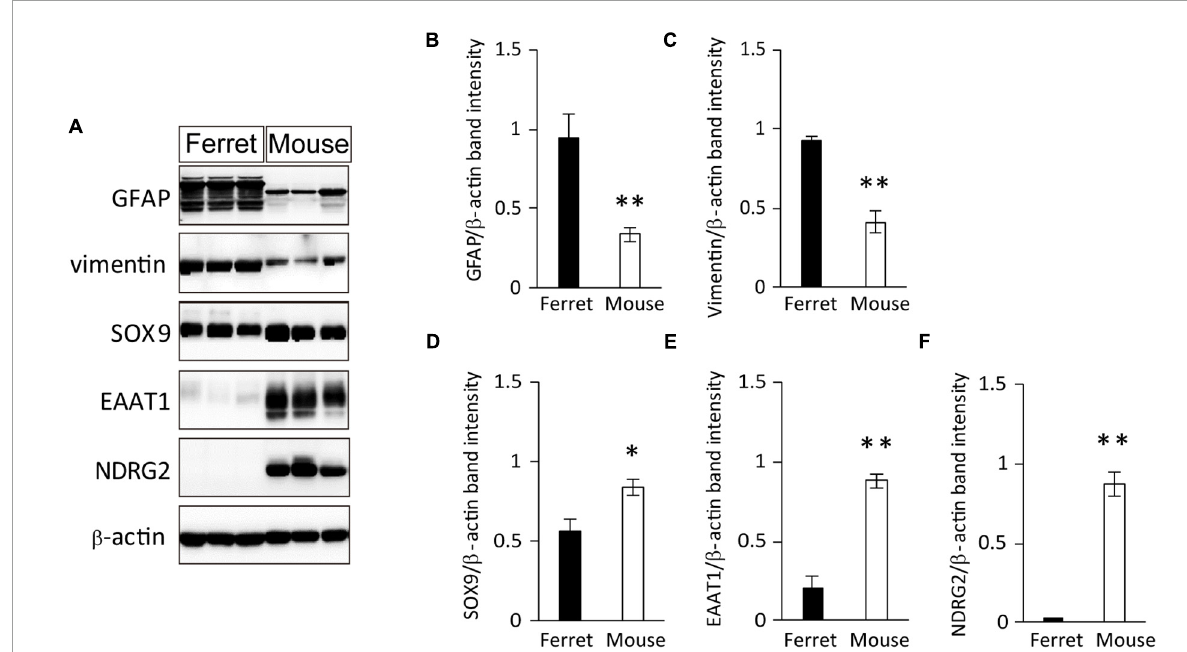
FIGURE2 Expression of astrocyte-specific markers. (A) Ferret and mouse astrocytes cultured with serum for 4 days were subjected to western blot analysis of astrocyte-specific markers GFAP, vimentin, SOX9, EAAT1, NDRG2, and β -actin. (B–F) Relative optical density of astrocyte-specific markers normalized to the loading control β -actin. n = 5 independent cultures. Data represent the means ± SEM. The P -values were determined using paired Student’s t -test. ∗ P < 0.05 and ∗∗ P <